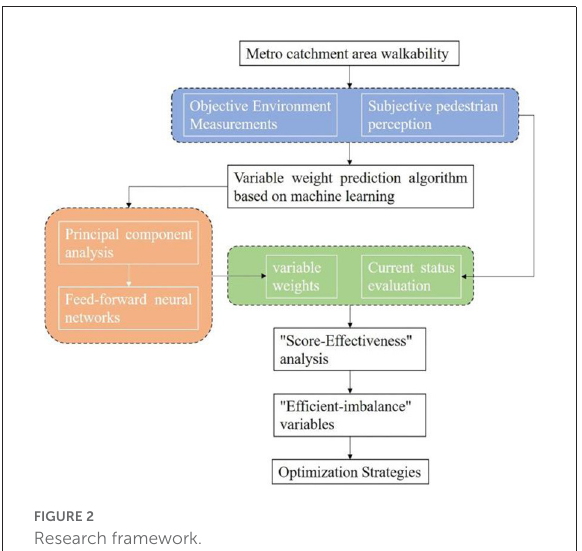
FIGURE2 Research